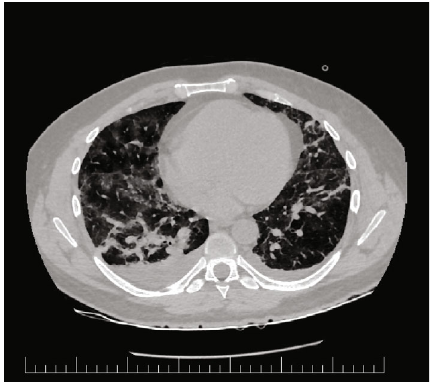
Figure 1: Patient ’ s chest X-ray.